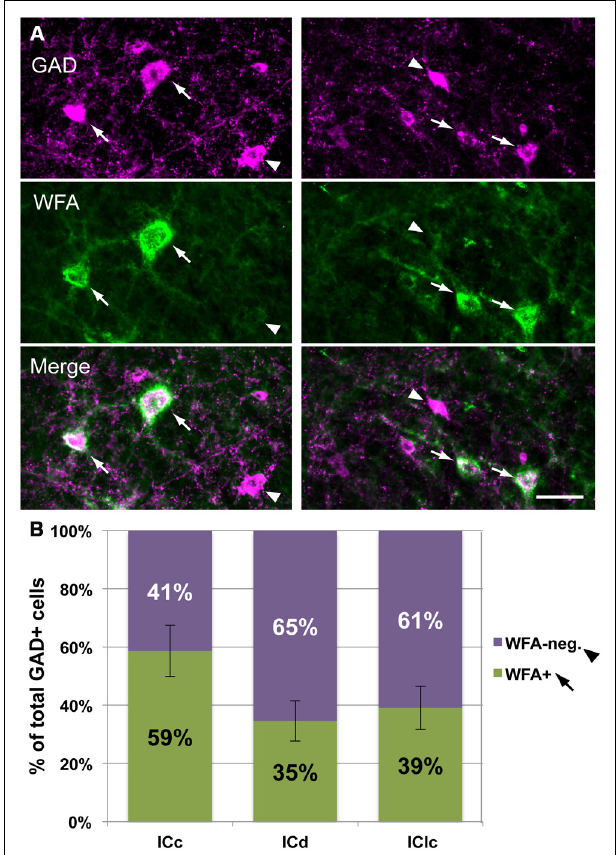
FIGURE 9 |A subset of IC GAD+ cells are surrounded byWFA-labeled PNs. (A) . Photomicrographs from ICc (left column) and IClc (right column) showing GAD + cells that are surrounded by PNs (arrows) and GAD + cells that are not surrounded by PNs (arrowheads).Top row: two different areas stained for GAD. Middle row: same areas as top row, showingWFA staining for PNs. Bottom row: merged image showing GAD + cells with or without PNs. Scale bar = 50 μ m. Case GP691. (B) . Graph showing the percentage of GAD + cells in each IC subdivision that are surrounded by PNs (green bars) or not surrounded by PNs (purple bars). Error bars = SEM; data were averaged across 74 sections in nine animals.